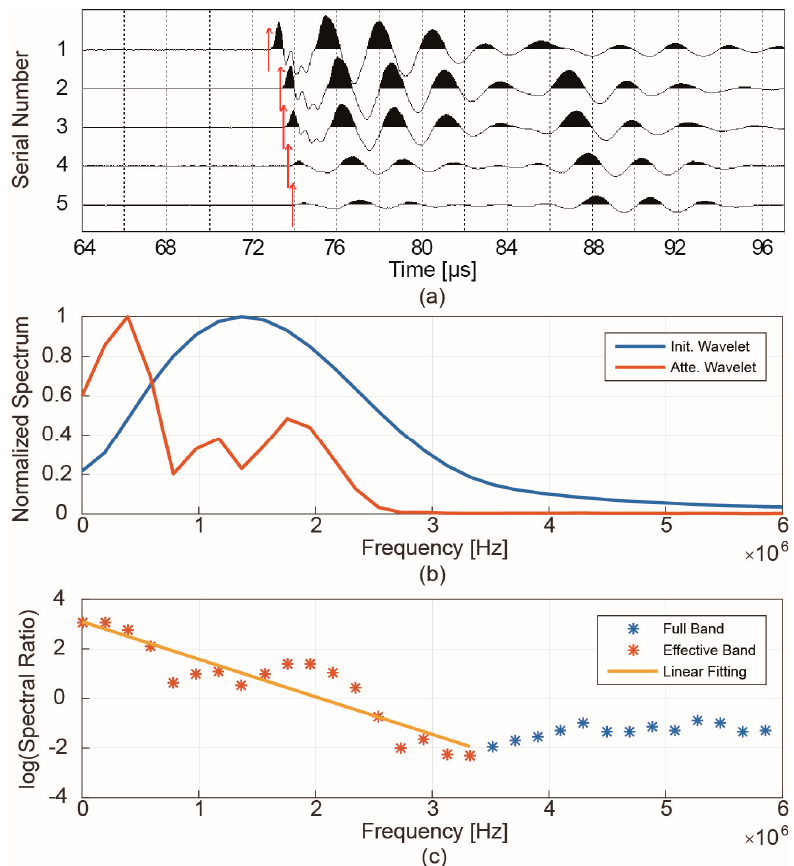
Figure 7. Example of received ultrasonic wave signals and spectral ratio calculation of the quality factor. ( a ) A set of P-wave signals received at sensor No. 5 and transmitted from sensor No. 11; ( b ) Normalized spectrum example of the initial unattenuated P-waveform and one attenuated first-arrival P-waveform; ( c ) Spectral ratio calculation of Q by using the effective frequency band.